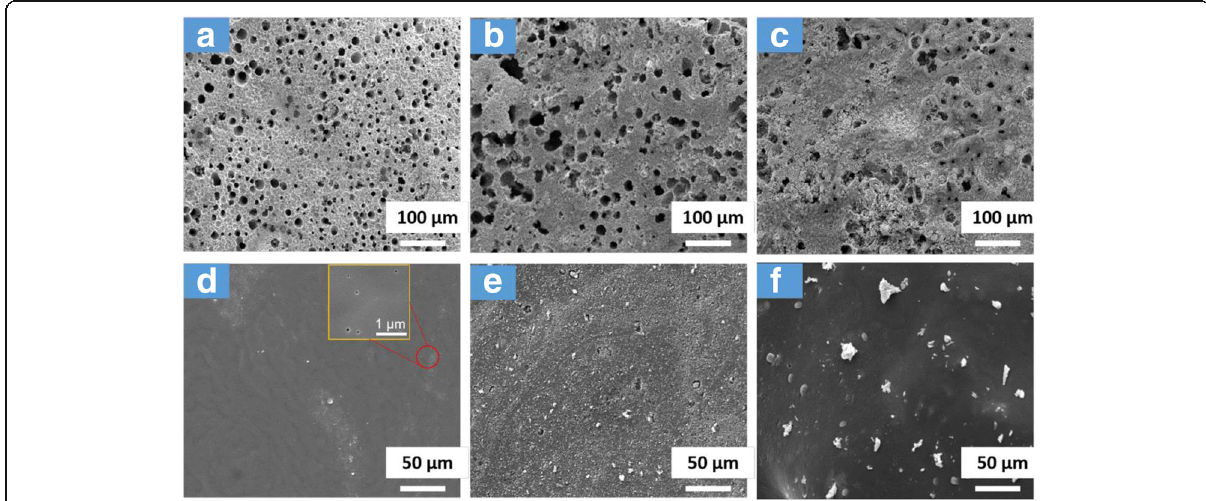
Fig. 8 SEM images of exterior and interior morphology of the residue chars of PVC ( a , d ) TNTs-PVC ( b , e ) and TNTs/GO-PVC ( c , f ) composites. The char of TNTs/GO-PVC was more compact and continuous than that of the neat PVC or TNTs-PVC